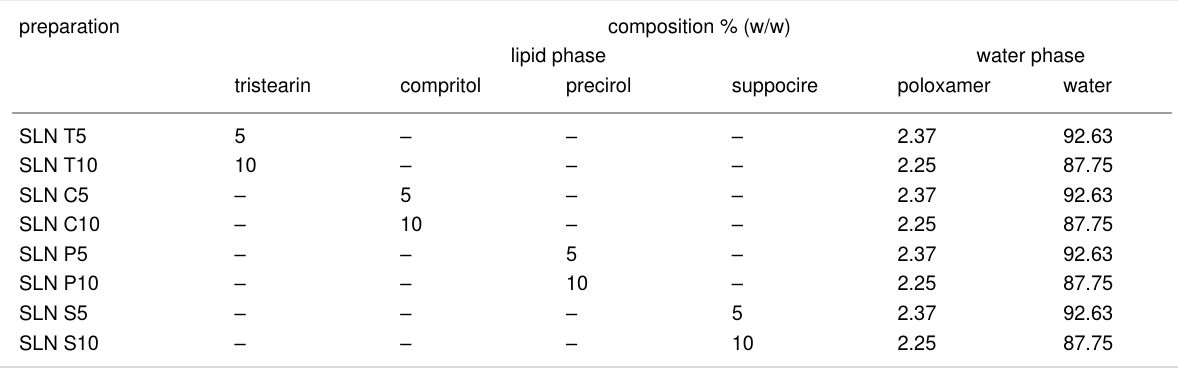
Table 1: Composition of solid lipid nanoparticles (SLNs). preparation